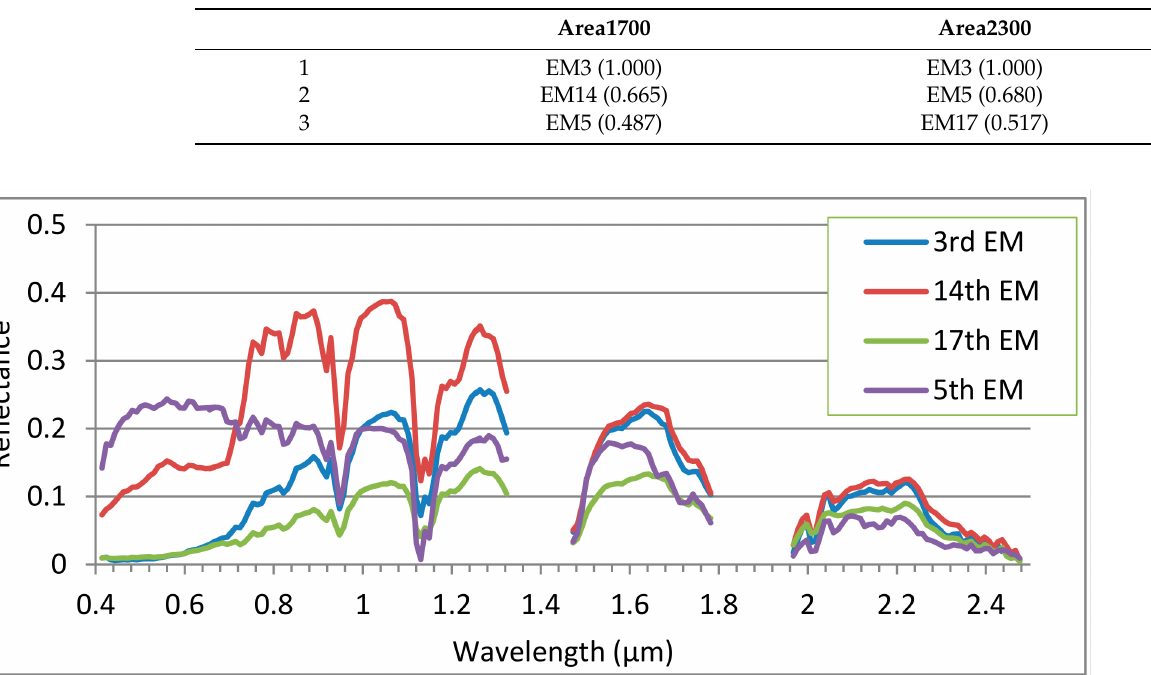
Figure 14. Spectral reflectance of the 3rd, 14th, 17th, and 5th